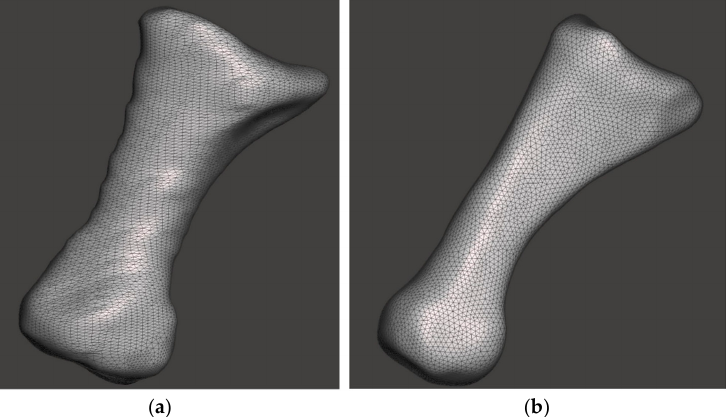
Figure 2. Os metatarsus primus 3D model original polygon mesh ( a ) and model with edited and optimized polygon mesh ( b ). A total of 28 models were optimized to correct the errors and artifacts that occurred during the segmentation process (Figure 3).